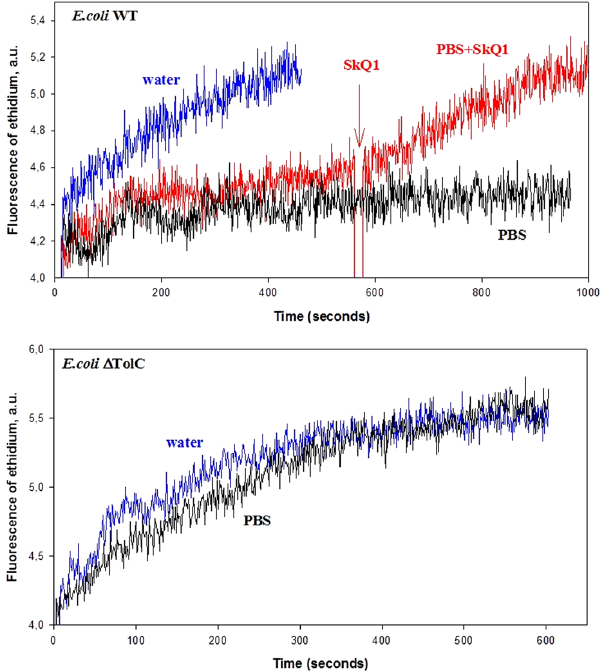
Figure 3. Effect of SkQ1 on ethidium bromide accumulation by WT (top panel) and Δ tolC (bottom panel) E. coli cells. E. coli cells were added to PBS with 20 μ M ethidium bromide (black) and SkQ1 was added subsequently after 8 min of incubation (red). Osmotic shock by deionized water was used as a control (blue).